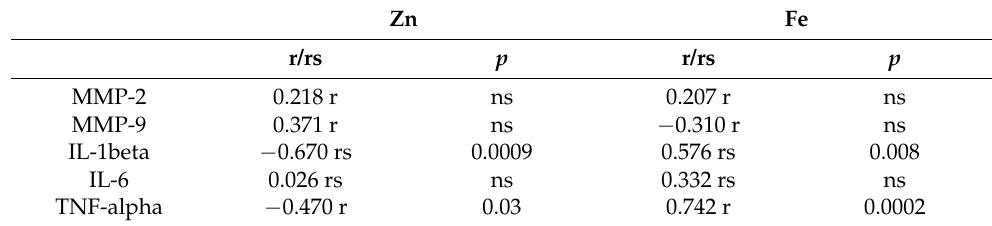
Table 7. Changes in fatty acids in rats fed MCD diet.